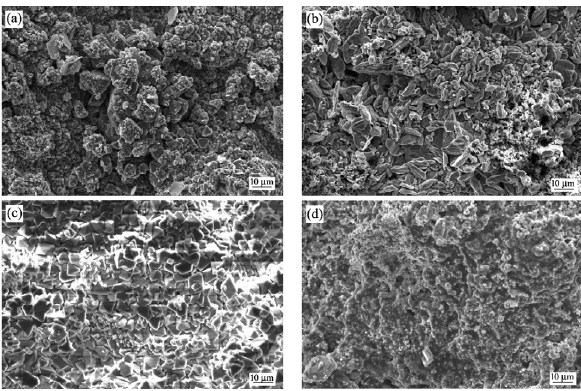
Figure 5: Surface morphology of Inconel 625 after corrosion in molten (a) NaCl, (b) KCl, (c) MgCl 2 and (d) CaCl 2 salts at